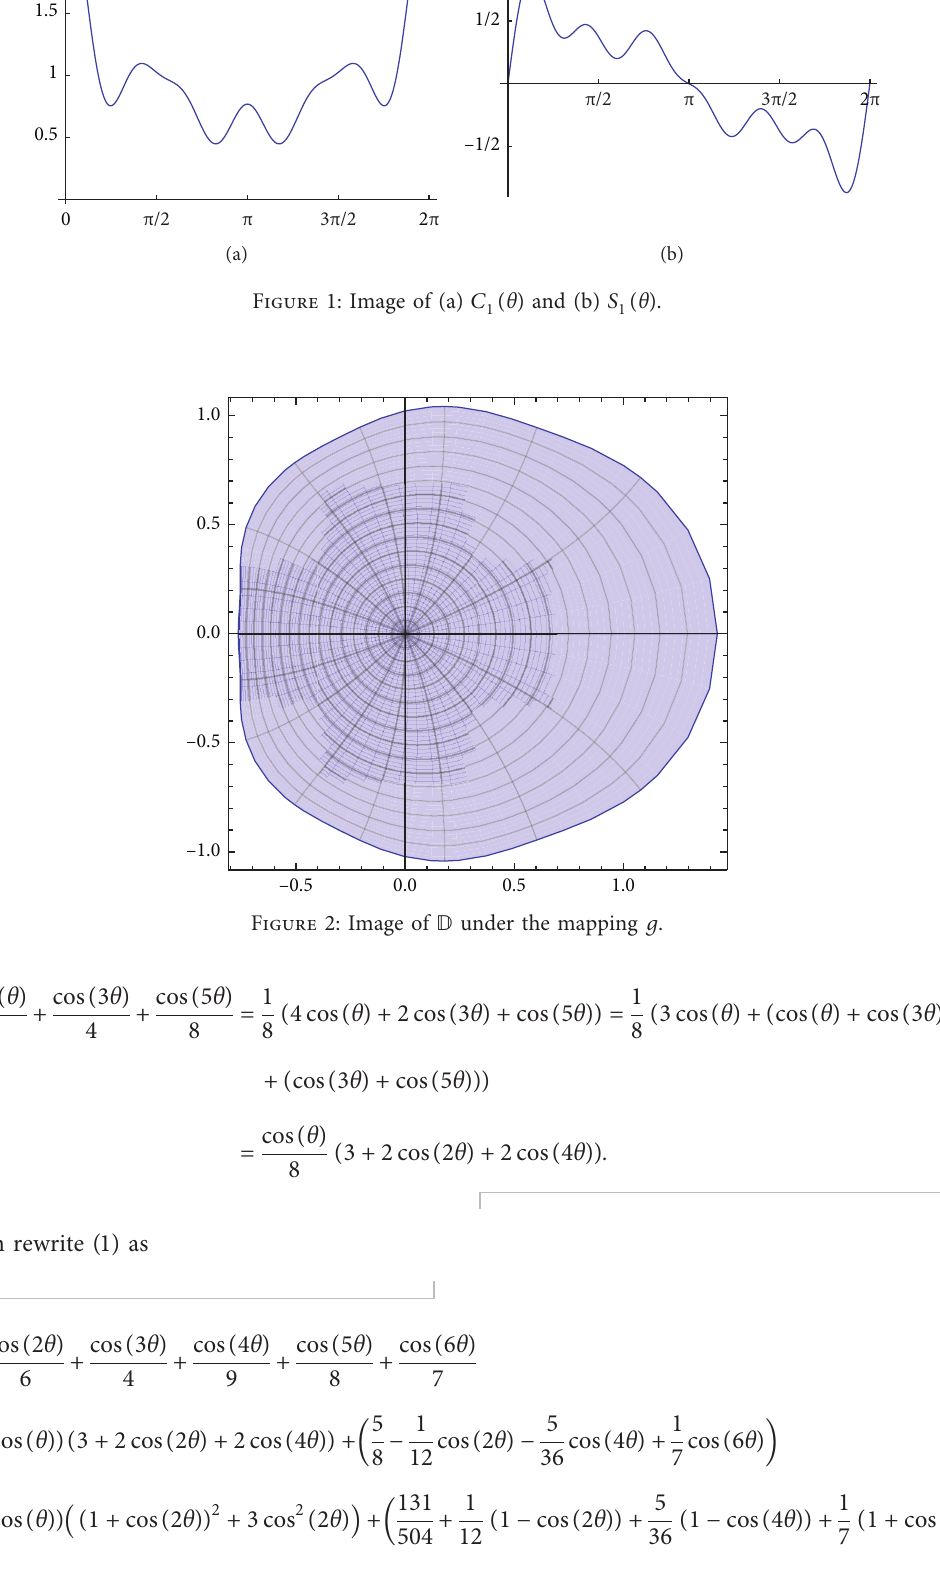
Figure 1: Image of (a) C